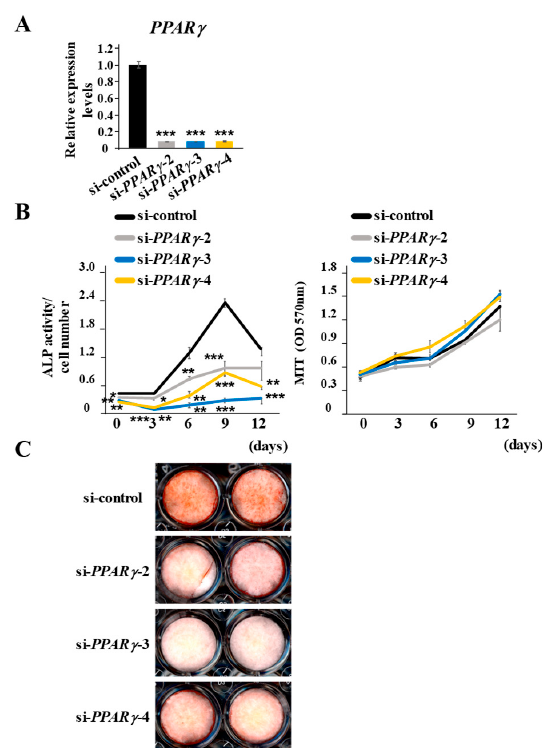
Figure A1. The knockdown of PPAR γ by 3 new independent siRNAs inhibits ALP activities and calcium deposition without affecting cell numbers. ( A – C ) PDLF-1 transfected with either si-control, si- PPAR γ -2, si- PPAR γ -3, or si- PPAR γ -4. ( A ) PPAR γ mRNA expression 24 h after transfection was analyzed using HPRT for normalization. ( B ) ALP activities were measured and cell numbers were enumerated by MTT every 3 days. ALP activities are normalized with MTT values. ( C ) Alizarin red S staining was performed on day 15. Data represent the mean ± SD of three independent experiments. * p < 0.05; ** p < 0.01; *** p < 0.001 significantly lower than in cells transfected with si-control.